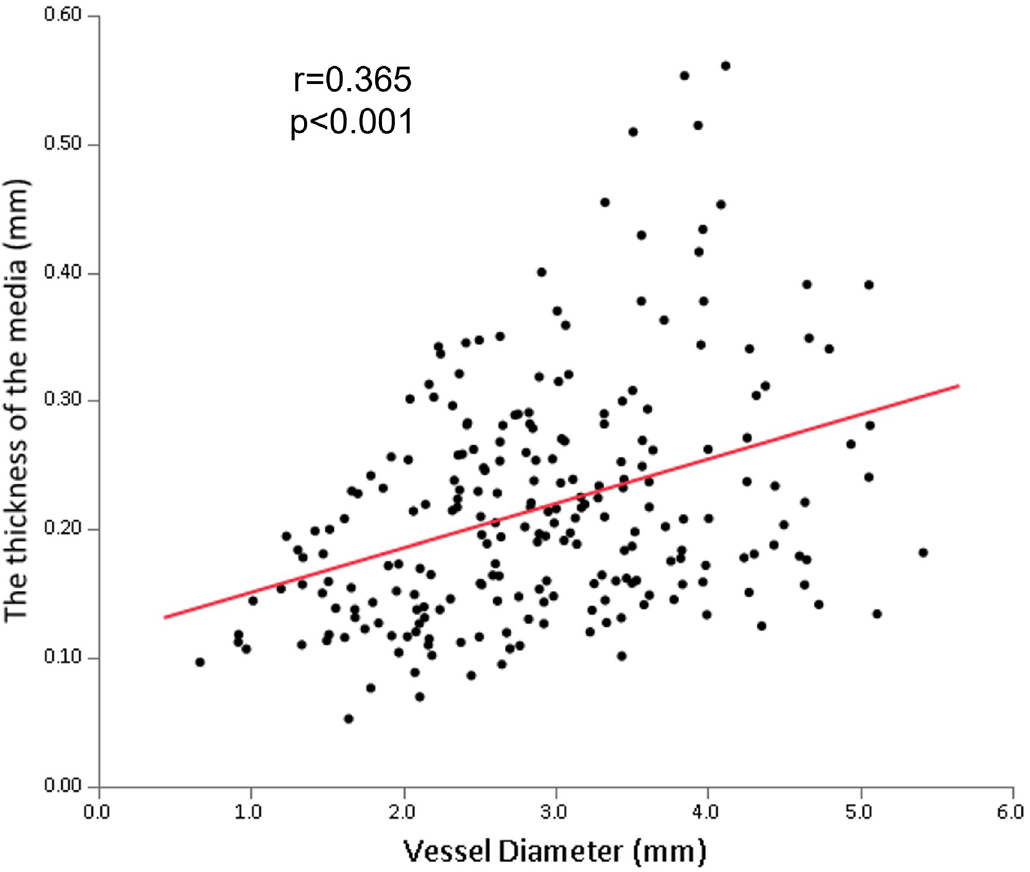
Fig 3. The relationship between the medial thicknesses and the vessel diameter. The thickness of the media directly correlated with the vessel diameter (r = 0.365, p < 0.001).